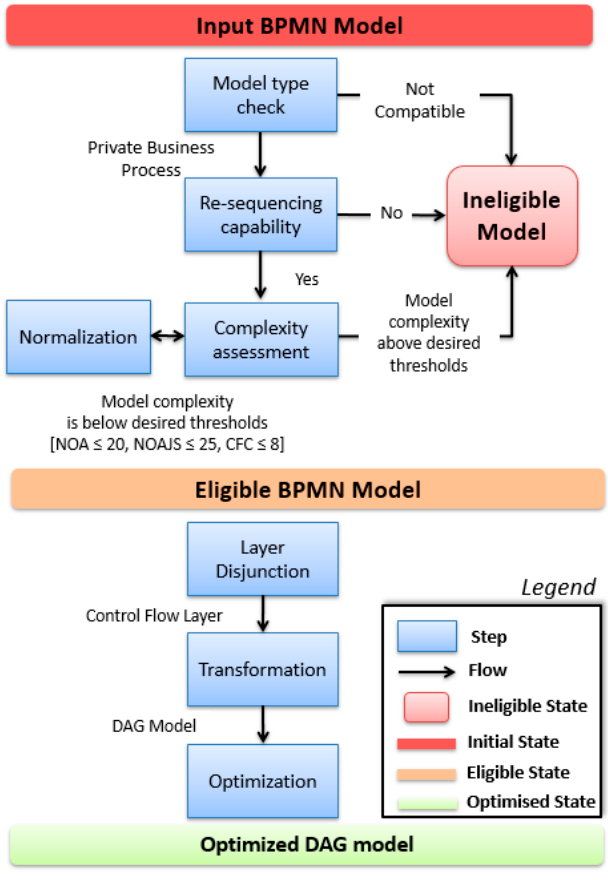
Figure 2. Eligibility assessment of BPMN models as an integral part of optimization.